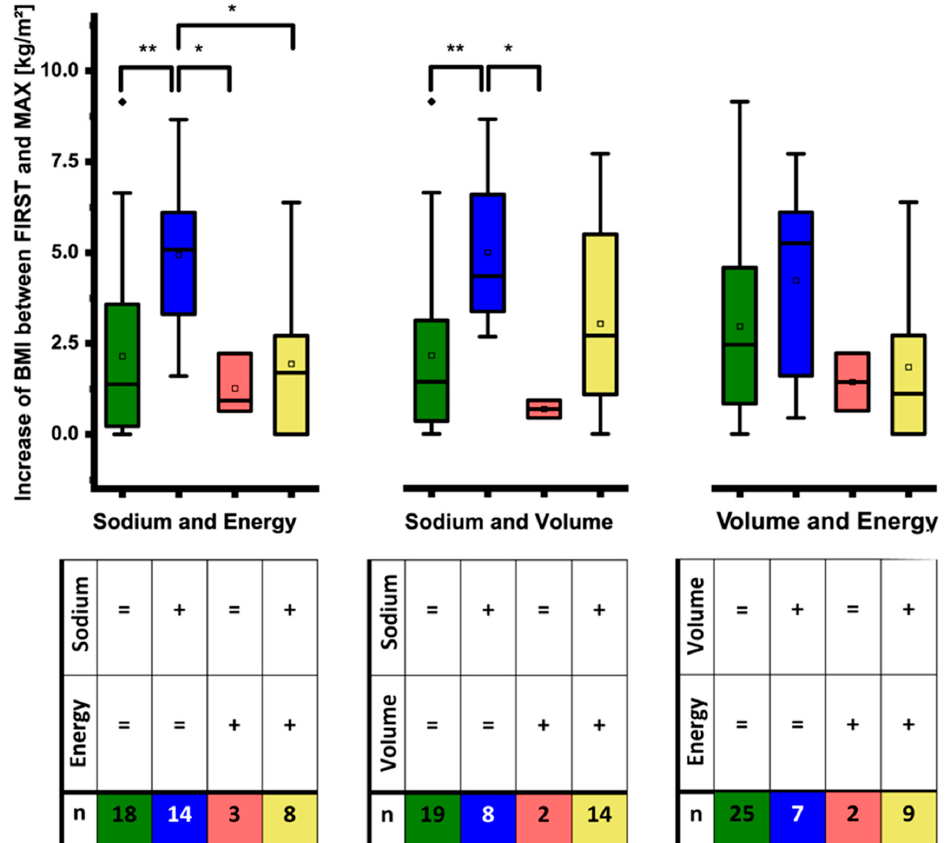
Figure 5. Impact of modifications of energy, volume, and sodium support on the increase in BMI between FIRST and MAX BMI . The table indicates if one of the two considered components of the parenteral support was intensified (+) or not (=) and how many patients were affected (groups 1 and 2; n = 43 in each panel). Intensification of only sodium support was highly significantly associated with the largest increase in BMI (blue boxes left and middle panel). These changes in sodium were the most frequent and the relatively most extensive. They mainly occurred in patients without colon in continuity. Of note, at FIRST there were no significant differences in the absolute BMI between the groups (not depicted in the figure) (* p < 0.05; ** p < 0.01).